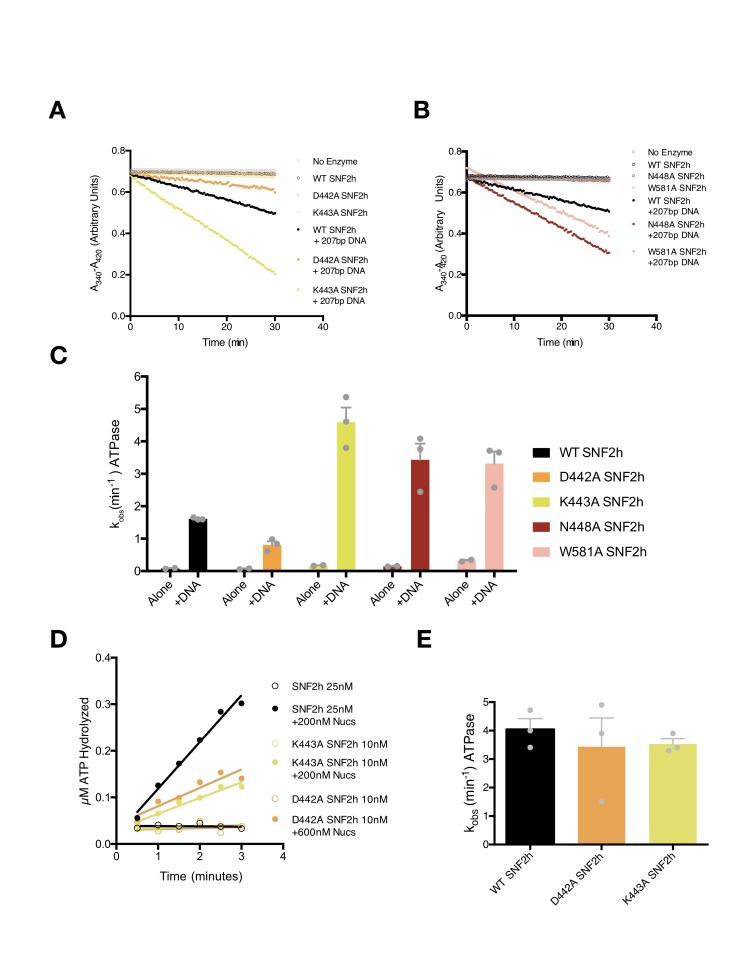
ATPase activities of point mutants in this study.(A–B) Example absorbance plots of the NADH coupled ATPase assay to measure DNA-stimulated ATPase activity. Reactions were performed with 800 nM of the indicated SNF2h constructs either without DNA (open circles) or with saturating concentrations (208 nM) of the 207 bp DNA used to assemble nucleosomes in our Cryo-EM reconstructions. (C) Mean and standard error of DNA-stimulated ATPase rate measurements for n = 3 experiments. All mutations tested had modest effects on DNA-stimulated hydrolysis rates (~2 fold or less). (D) Example plot of radioactive ATP hydrolysis reactions used to measure nucleosome-stimulated ATPase activity. Reactions were performed with the indicated concentrations of SNF2h and nucleosomes without flanking DNA. The concentrations of nucleosomes used were confirmed to be saturating by this assay while the concentration of ATP-MgCl2 used was subsaturating (20 µM). (E) Mean and standard error of nucleosome-stimulated ATPase rate measurements from n = 3 measurements. All rate constants measured were within error of each other.10.7554/eLife.46057.020Figure 3—figure supplement 5—source data 1.Values used to obtain plots.